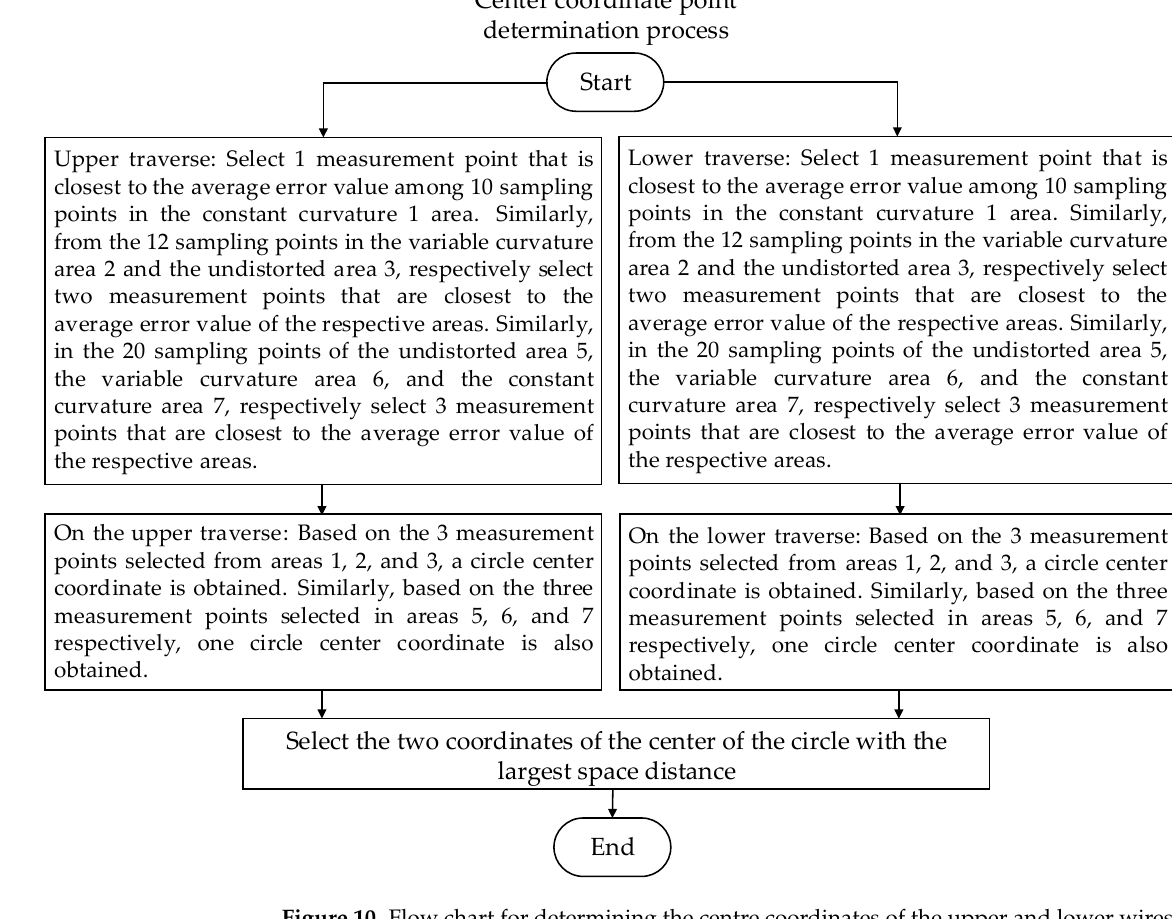
Figure 10. Flow chart for determining the centre coordinates of the upper and lower wires.